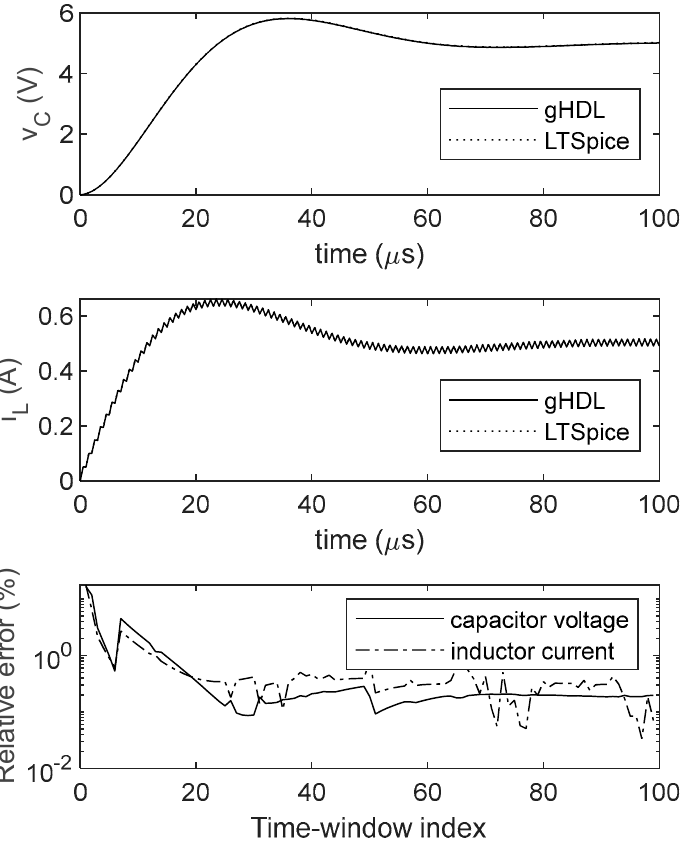
Figure 3. Ideal buck power stage waveforms. The first and second plots are the capacitor voltage and inductor current waveforms obtained in gHDL and LTSPICE simulation, respectively. The relative error is drawn in the third plot.